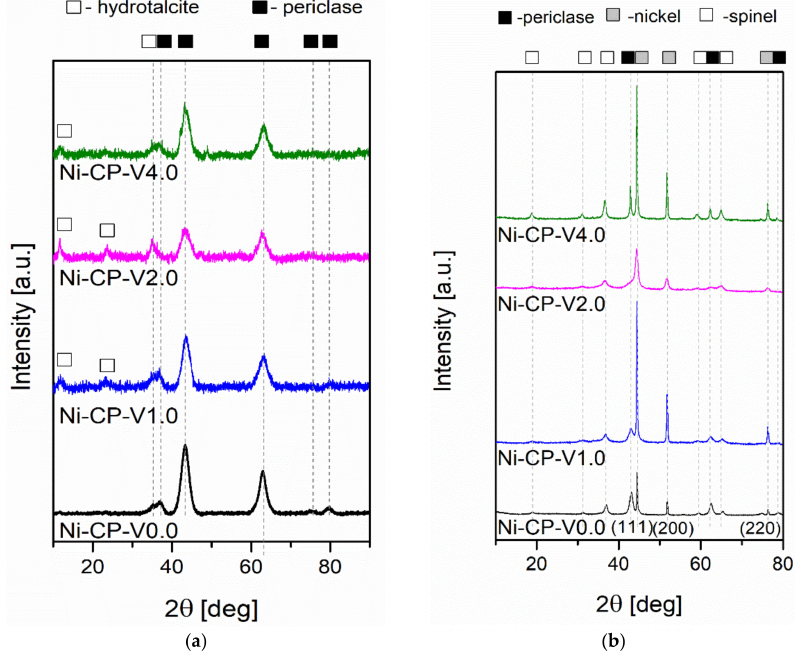
Figure 4. XRD diffractograms for ( a ) catalysts after calcination; ( b ) catalysts after